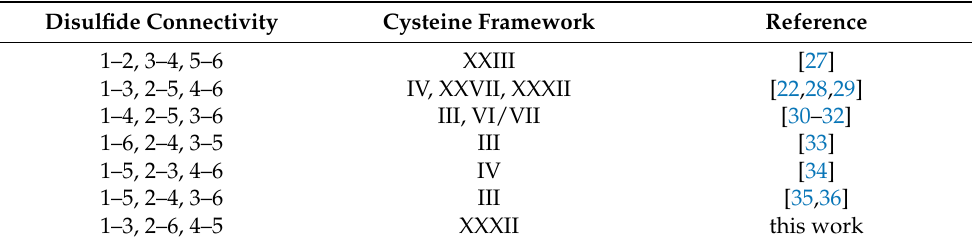
Table 2. Common connectivities of cysteine frameworks with six